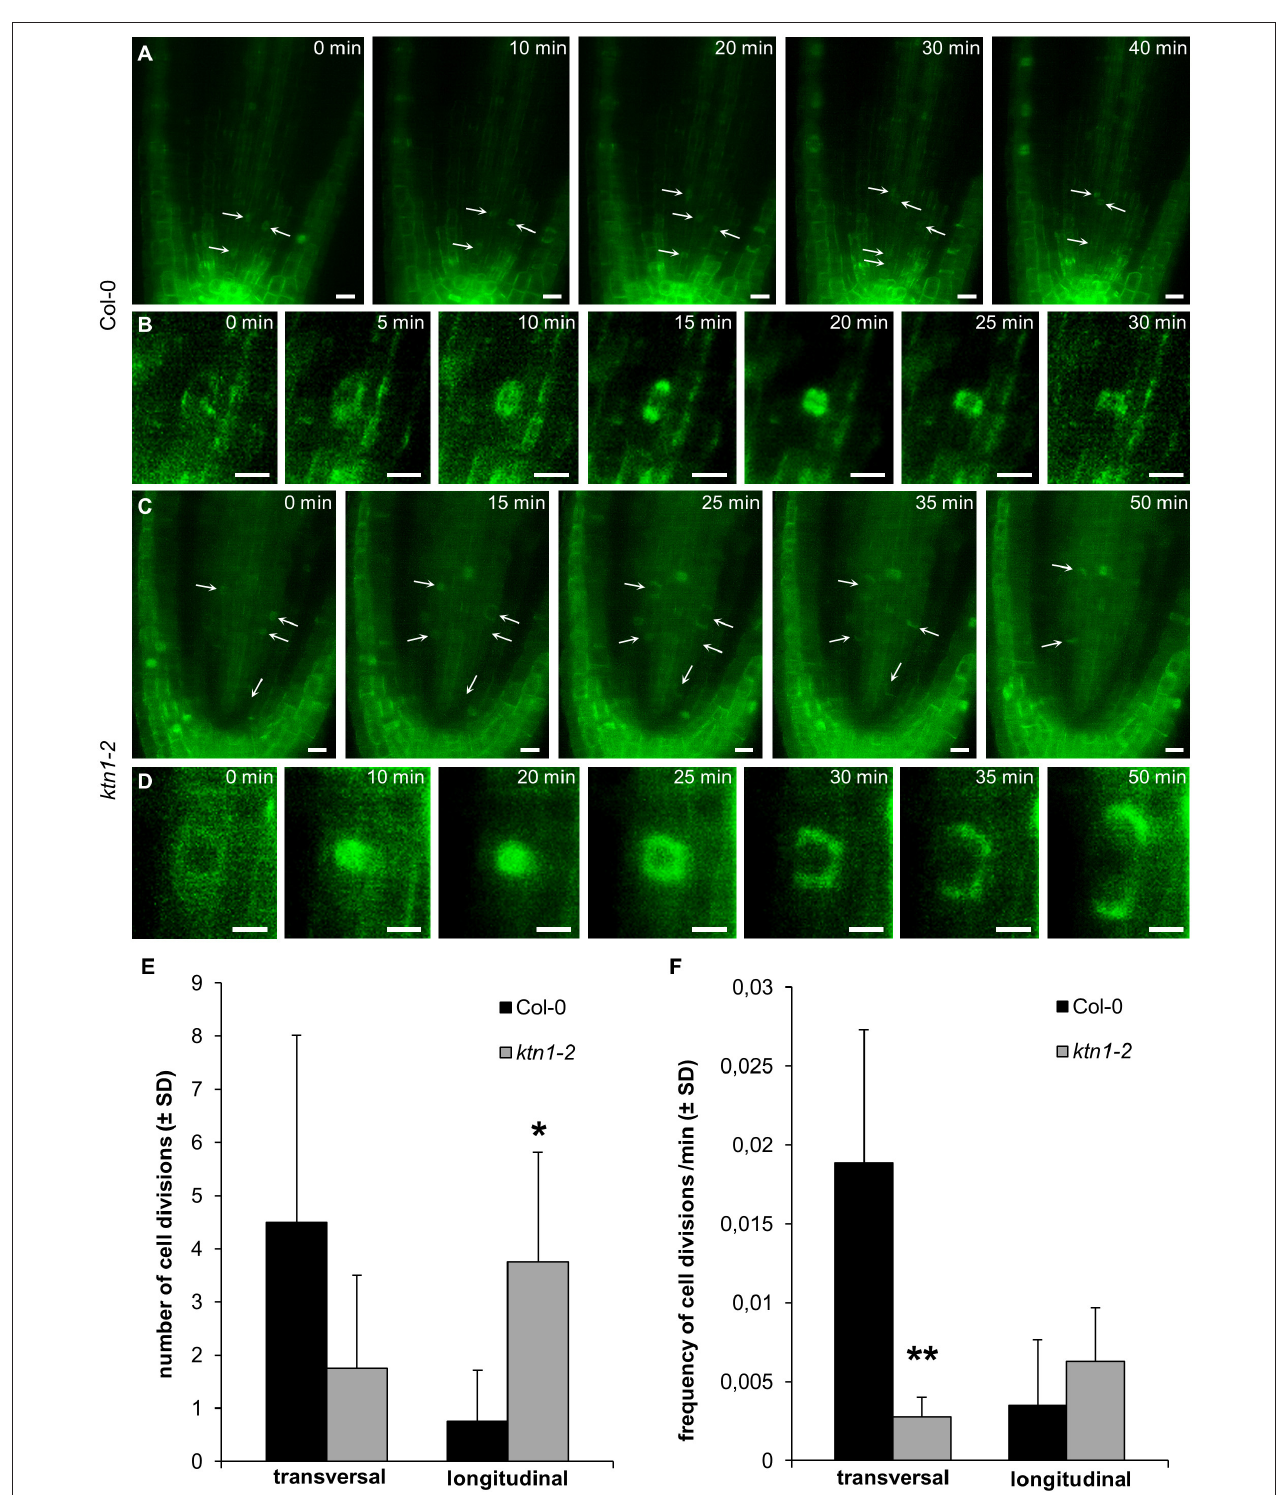
FIGURE 5 | Cell divisions in procambium of the primary root apex of plants stably expressing a GFP-TUA6 microtubule marker. (A,B) Proliferative transversal cell divisions in procambium of Col-0 (arrows). Progression of one representative cell division is depicted in (B) . (C,D) Longitudinal cell divisions in procambium of ktn1-2 mutant (arrows). Progression of one representative cell division is depicted in (D) . (E,F) Absolute numbers (E) and frequency/min (F) of proliferative transversal and longitudinal cell divisions in procambium of Col-0 and ktn1-2 mutant. Calculations are based on data collection from 4 seedlings. Asterisks indicate statistical significance between measurements (* p < 0.05, ** p < 0.01). Bars: (A,C) 10 µ m; (B,D) 5 µ m.